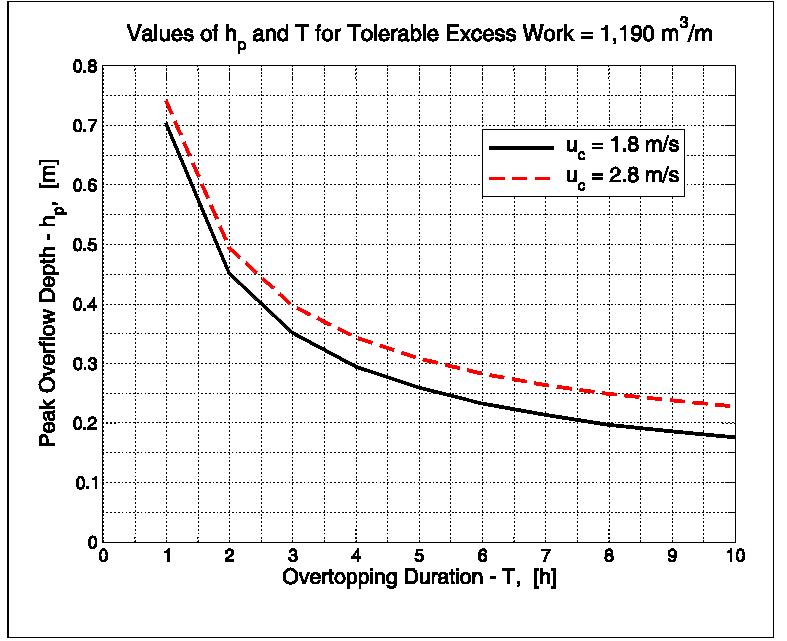
Figure 8. Equivalence pairs of peak overflow depth and overtopping duration that produce tolerable cumulative excess work of V ET = 1190 m 3